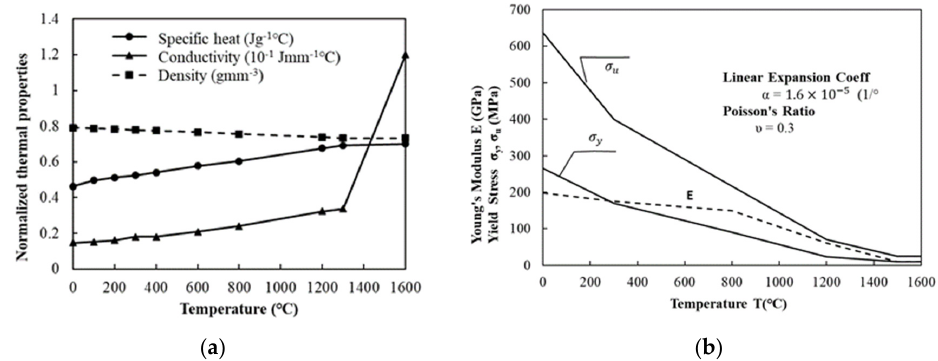
Figure 2. Temperature-dependent material properties of STS304: ( a ) physical properties; ( b ) mechanical properties.